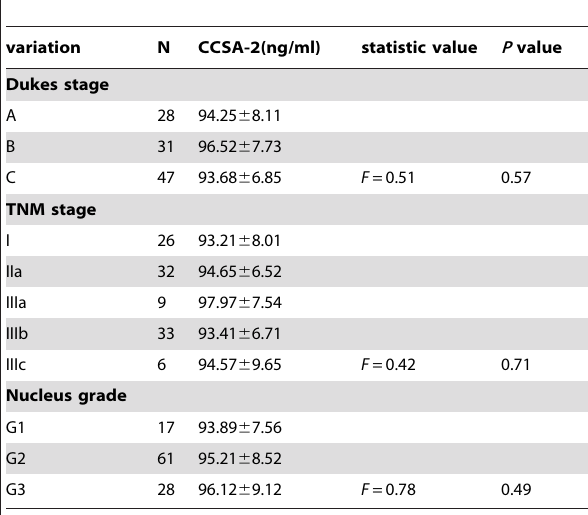
Table 2. CCSA-2 expression in different tumor stages and different tumor grades.